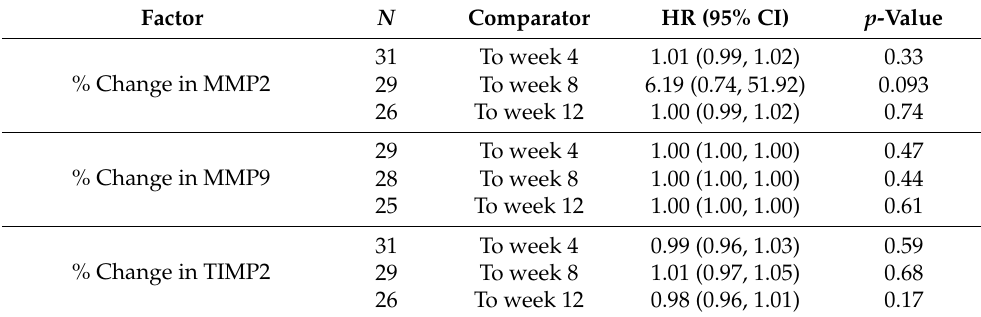
* Statistically significant at the α = 0.05 level in univariate analysis. After adjusting for ECOG status, no other factor was statistically significant.